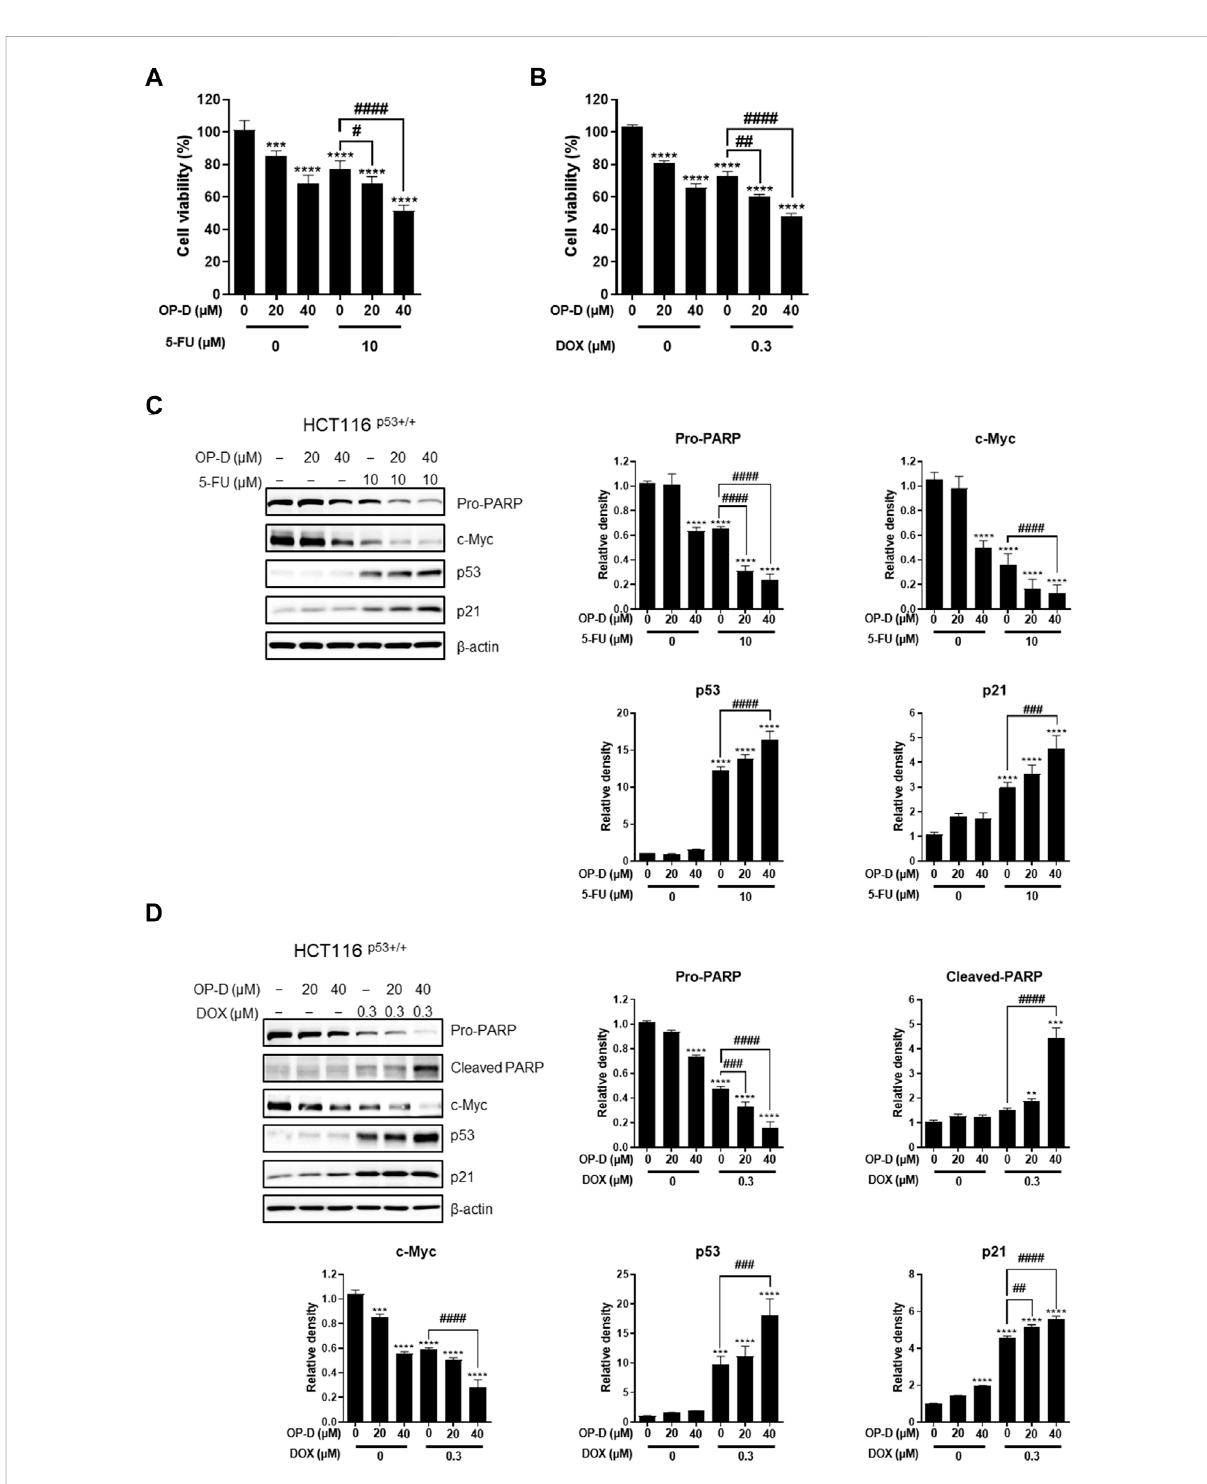
FIGURE 10 Combination effect of OP-D and 5-FU or doxorubicin in HCT116 p53+/+ cells. (A) HCT116 p53+/+ cells were treated with or without OP-D (20 or 40 μ M) and 5-FU (10 μ M) for 24 h. (B) HCT116 p53+/+ cells were treated with or without OP-D (20 or 40 μ M) and doxorubicin (0.3 μ M) for 24 h. (C) Then, cells were collected and performed by Western blotting with various antibodies. (D) Then, cells were collected and performed by Western blotting with various antibodies. Data represent means ± SD. ** p < 0.01, *** p < 0.005, **** p < 0.001, ## p < 0.01, ### p < 0.005, #### p <